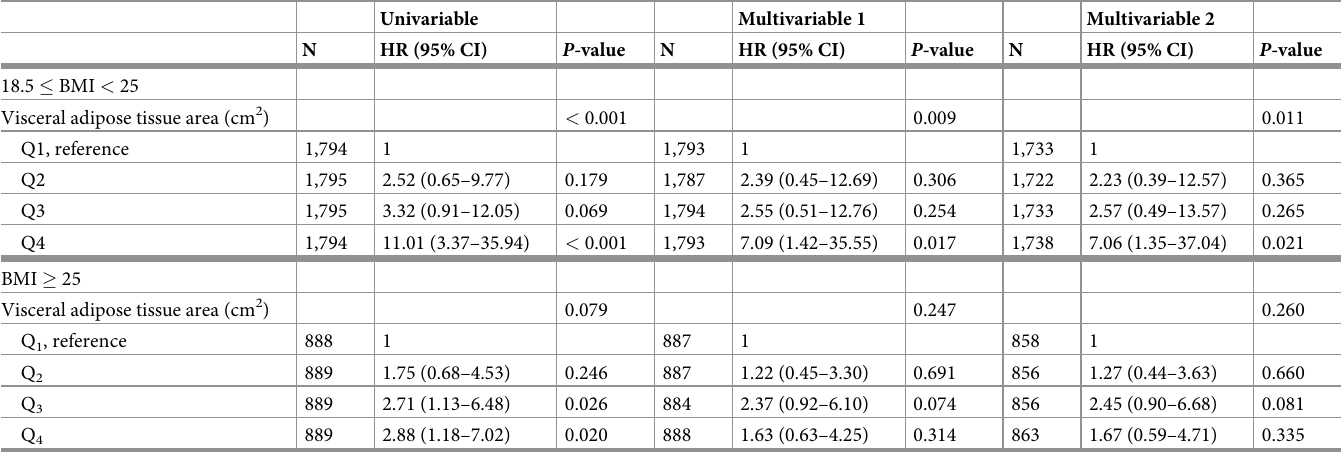
Table 3. The risk of chronic kidney disease in relation to the visceral adipose tissue area according to body mass index (n = 10,733).